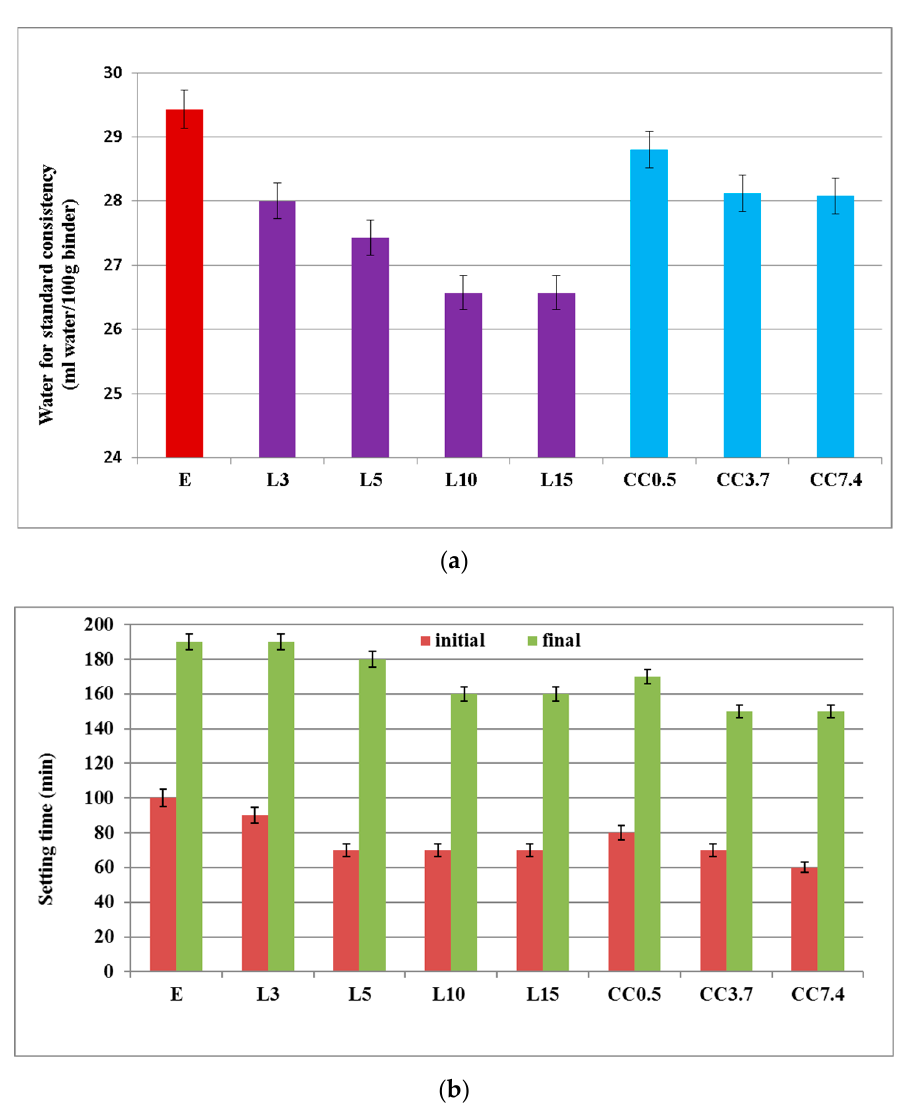
Figure 6. Water for standard consistency ( a ) and setting time ( b ) of binding pastes. For all studied pastes, the setting time decreases with the increase of calcium carbonate content (Figure 6b); the CaCO 3 particles act as crystallization sites for the newly formed hydrates (in the reaction of PC with water). The smaller values for final setting time assessed for the composition with nano-carbonate (see for example CC7.4 compared with L5) can be also due to the high fineness of calcium carbonate (nano powder). The evolution of mechanical strengths was assessed on mortars hardened for 3, 7 and 28 days—Figure 7. As expected, both compressive and flexural strengths increase with the increase in curing time from 3 to 28 days, due to the development of PC hydration and the hardening process. The substitution of PC with 3% and 5% limestone filler does not substantially modify the mechanical strengths with reference to E (PC), but the increase in substitution rate has a negative influence especially after 28 days of hardening. This is explained by the dilution effect of cement—limestone filler substitutes for the PC which is the active component of the binder (see Table